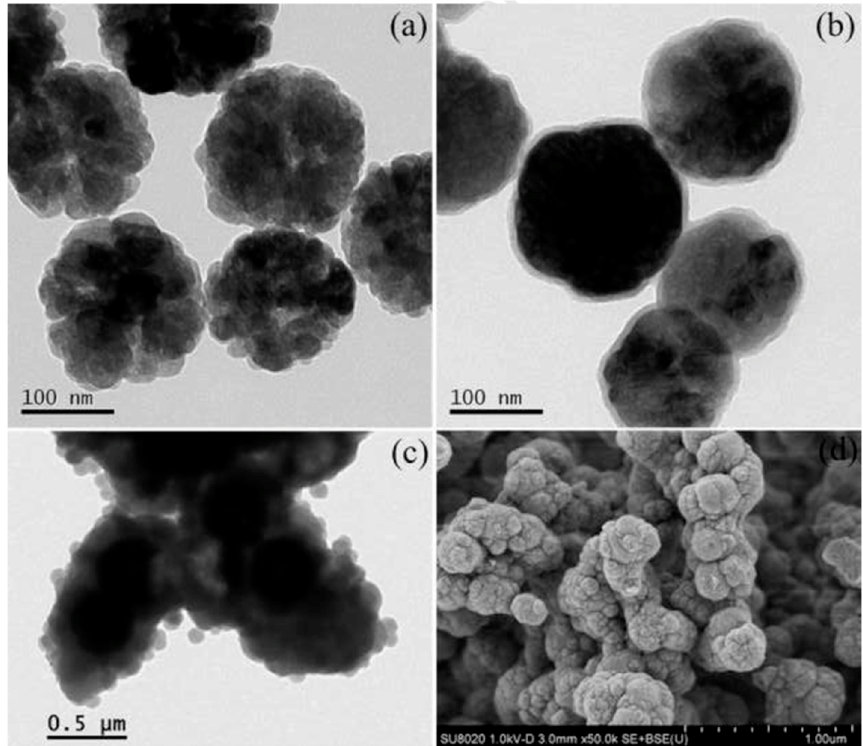
Figure 9. TEM images of Fe 3 O 4 nanoparticles ( a ), after coating with SiO 2 (Fe 3 O 4 @SiO 2 ) (b), of the final nanocomposite Fe 3 O 4 @SiO 2 @UiO-66 ( c ), and SEM of Fe 3 O 4 @SiO 2 @UiO-66 ( d ). Adapted with permission from [106]. Copyright (2015) Elsevier.